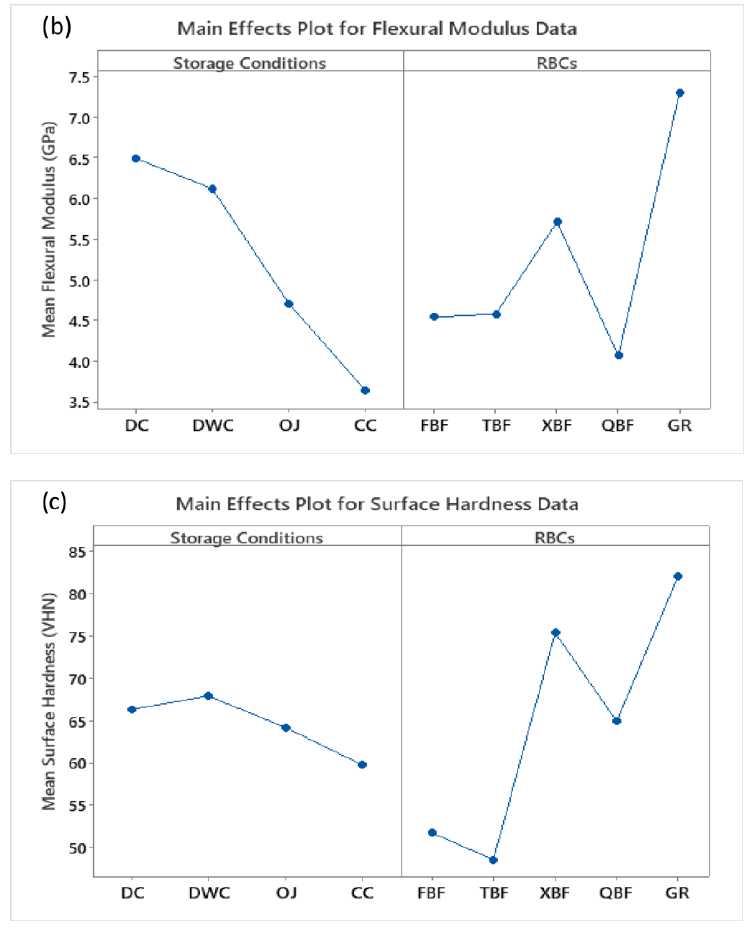
Figure 3. The main effect plots of ( a ) flexural strength, ( b ) flexural modulus, and ( c ) surface hardness data emphasize the major effect of storage condition and RBC type. The specimens stored in the ‘CC’ beverage exhibited the lowest surface hardness, flexural strength, and flexural modulus values compared to other storage conditions. The GR RBC reveals the highest surface hardness, flexural strength, and flexural modulus values in contrast to all bulk-fill